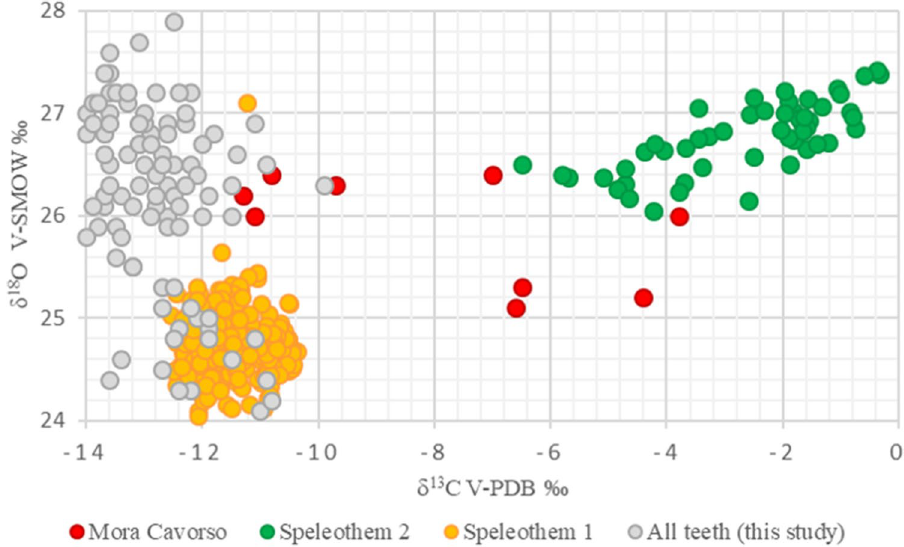
Figure 6. Bioapatite measurements plotted against the values of two speleothems sampled from Mora Cavorso (MC) cave. Speleothem 1: Speleothem formed during the MIS5, ca. 126 kilo years ago; Speleothem 2: Holocene speleothem. All teeth label refers to the analyzed teeth except for Mora Cavorso (MC)